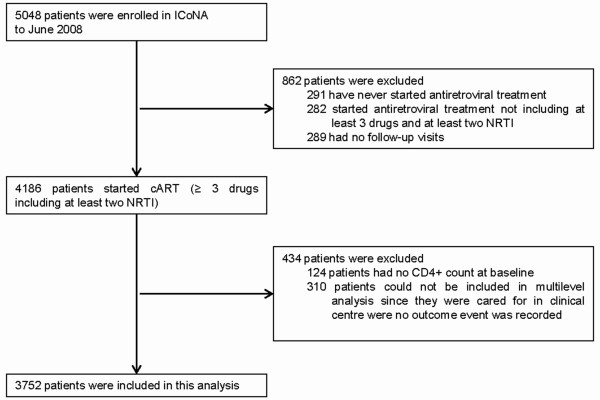
Flow diagram of patients included in this analysis.